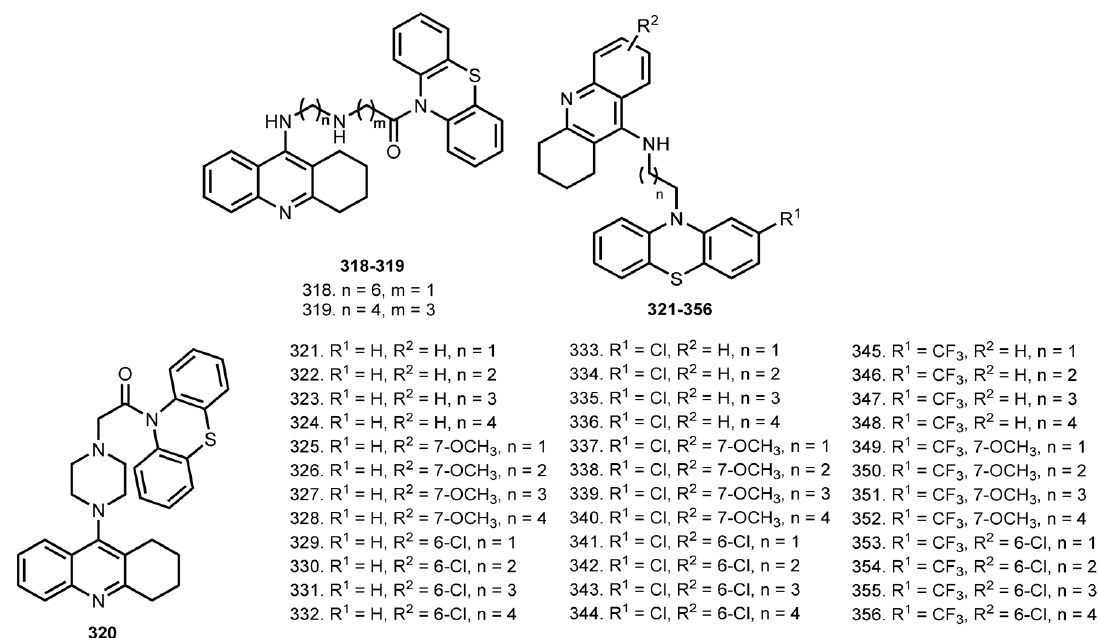
Figure 12. THA–phenothiazine hybrids 318 – 320 [66], 321 – 356